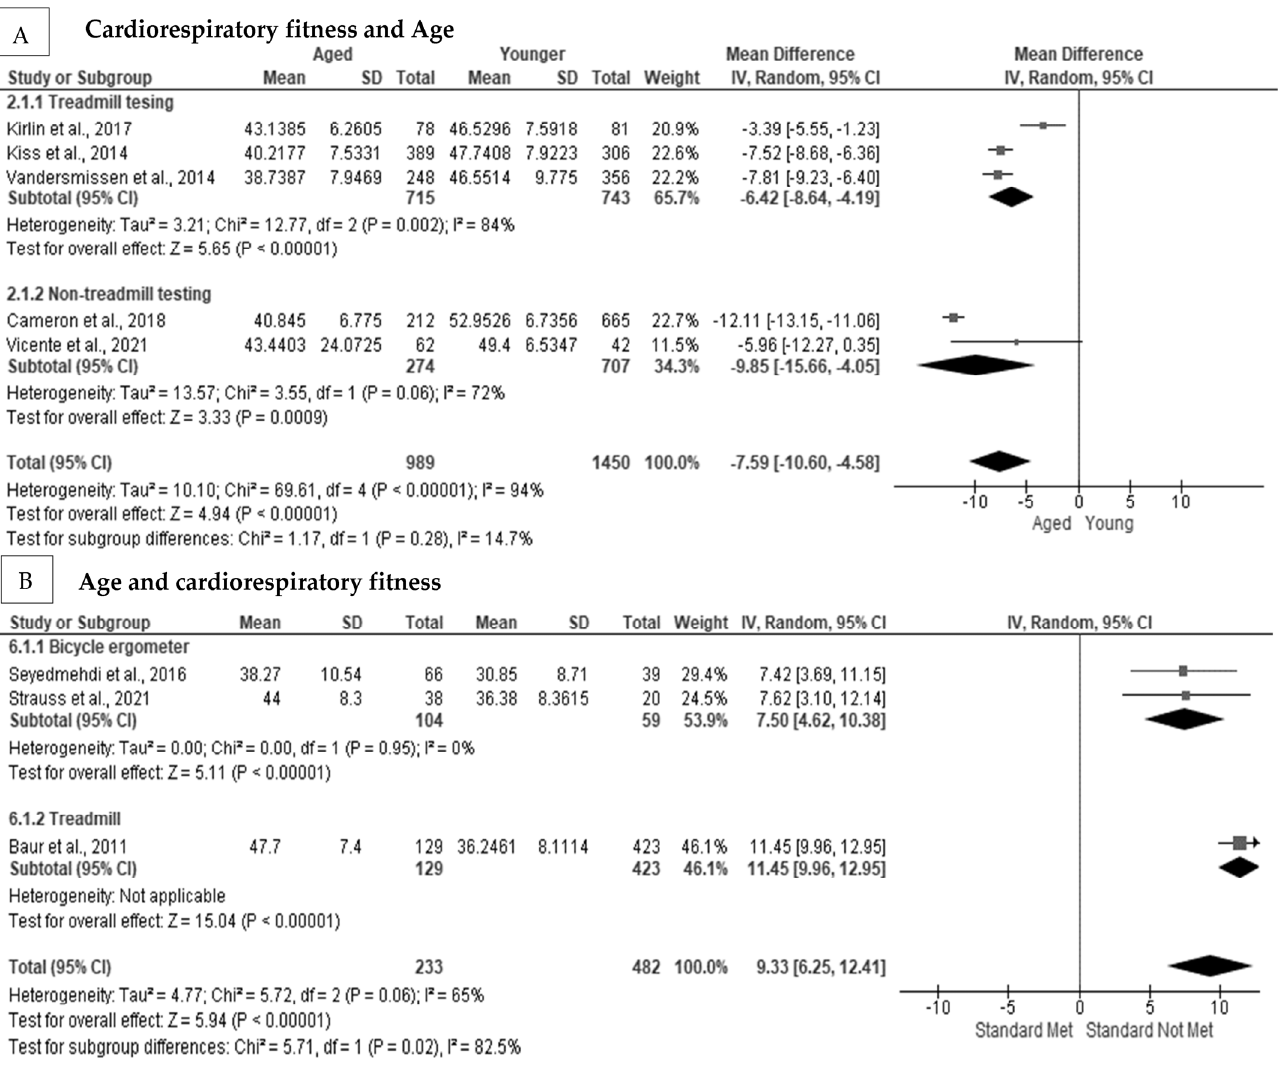
Figure 2. The association between age and cardiorespiratory fitness in firefighters: ( A ) The association between age and cardiorespiratory fitness with subgroup analysis [71,74,75,83,84]; ( B ) the association between cardiorespiratory fitness and age with subgroup analysis [30,40,69].